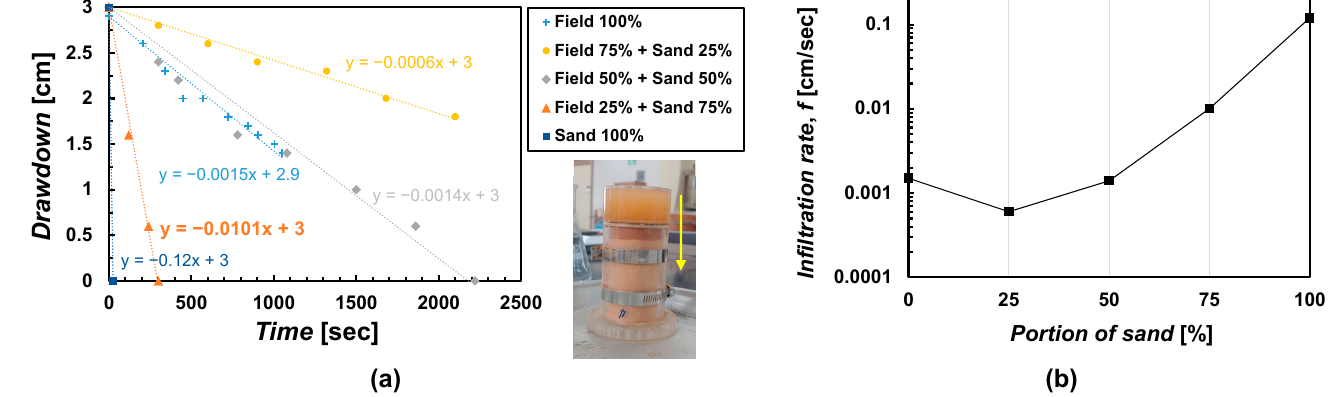
Figure 2. ( a ) Infiltration test results and ( b ) infiltration rates according to mixing ratio. The surface spraying method requires a sufficient level of f , but the f was too low to test as 0.0015, 0.0006, and 0.0014 cm/s, before the mixing ratio of standard sands reached more than 75% (Figure 2a). At least 75% of the portion of sand was determined as a minimum ratio to perform a test in this study. Therefore, in this study the mixture of 25% field soil + 75% standard sand was used in the case of the surface spraying method. The mixture of 25% field soil + 75% standard sand showed a maximum dry unit weight ( γ d(max) ) of 17.6 kN/m 3 and an optimum water content ( w opt ) of 15.6% under standard compaction energy. It is classified as SP by USCS. This mixture is herein called a 1:3:0 sample (mass ratio of field soil: fine aggregate: coarse aggregate). The particle size distribution is shown in Figure 3.